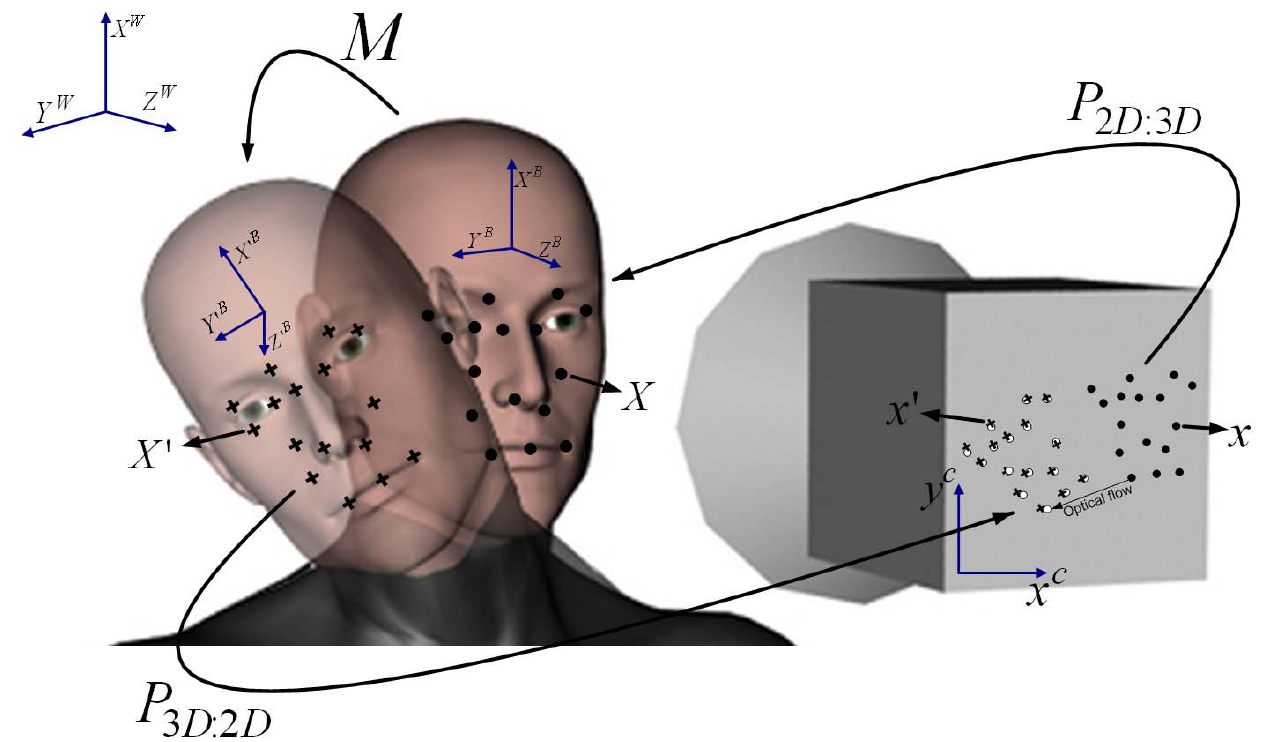
Figure 4. Transformation of the salient points involved on the proposed